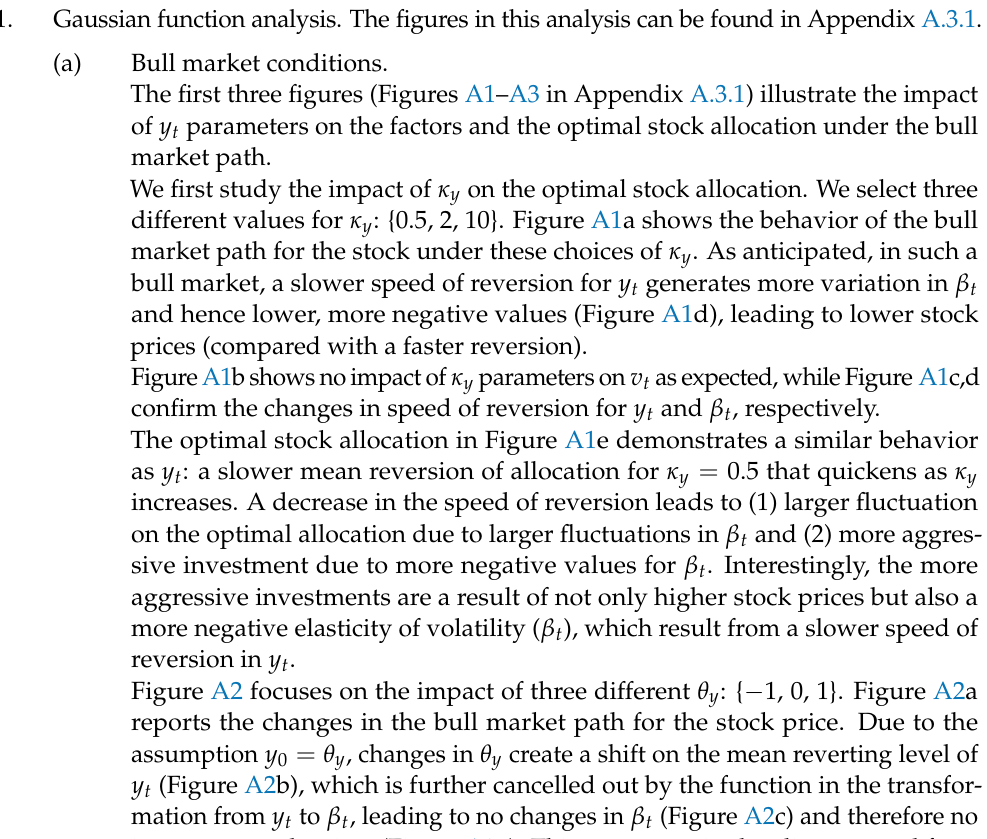
Figure A2 focuses on the impact of three different θ y : { − 1, 0, 1}. Figure